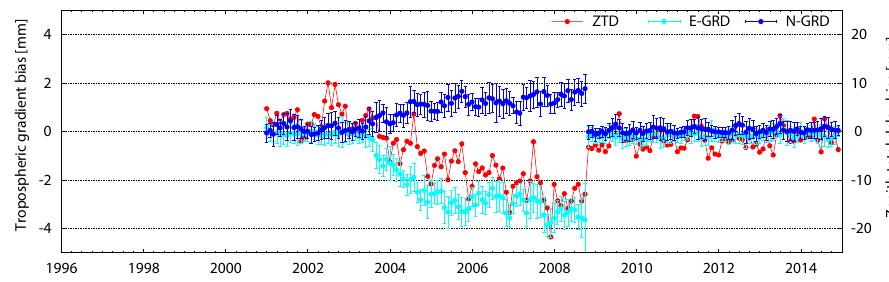
Figure 4. MALL station – monthly mean differences in tropospheric horizontal gradients with respect to the